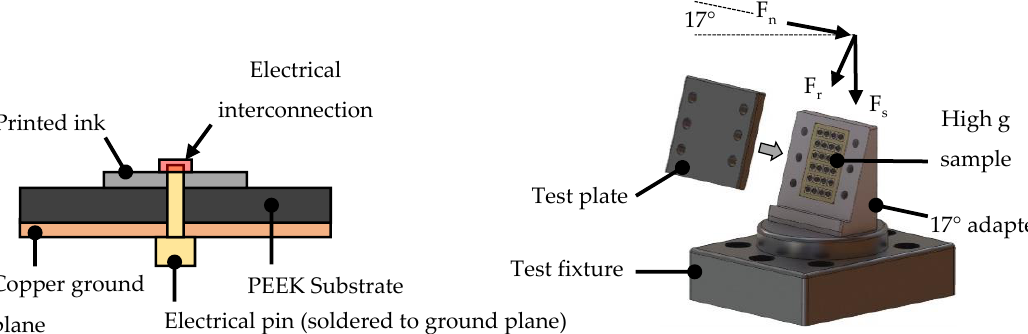
Figure 2. Design of electrical interconnection high g sample ( left ) and diagram of high g test fixture ( right ). The resultant impact force (F r ) is a combination of both shear (F s ) and normal (F n ) forces.